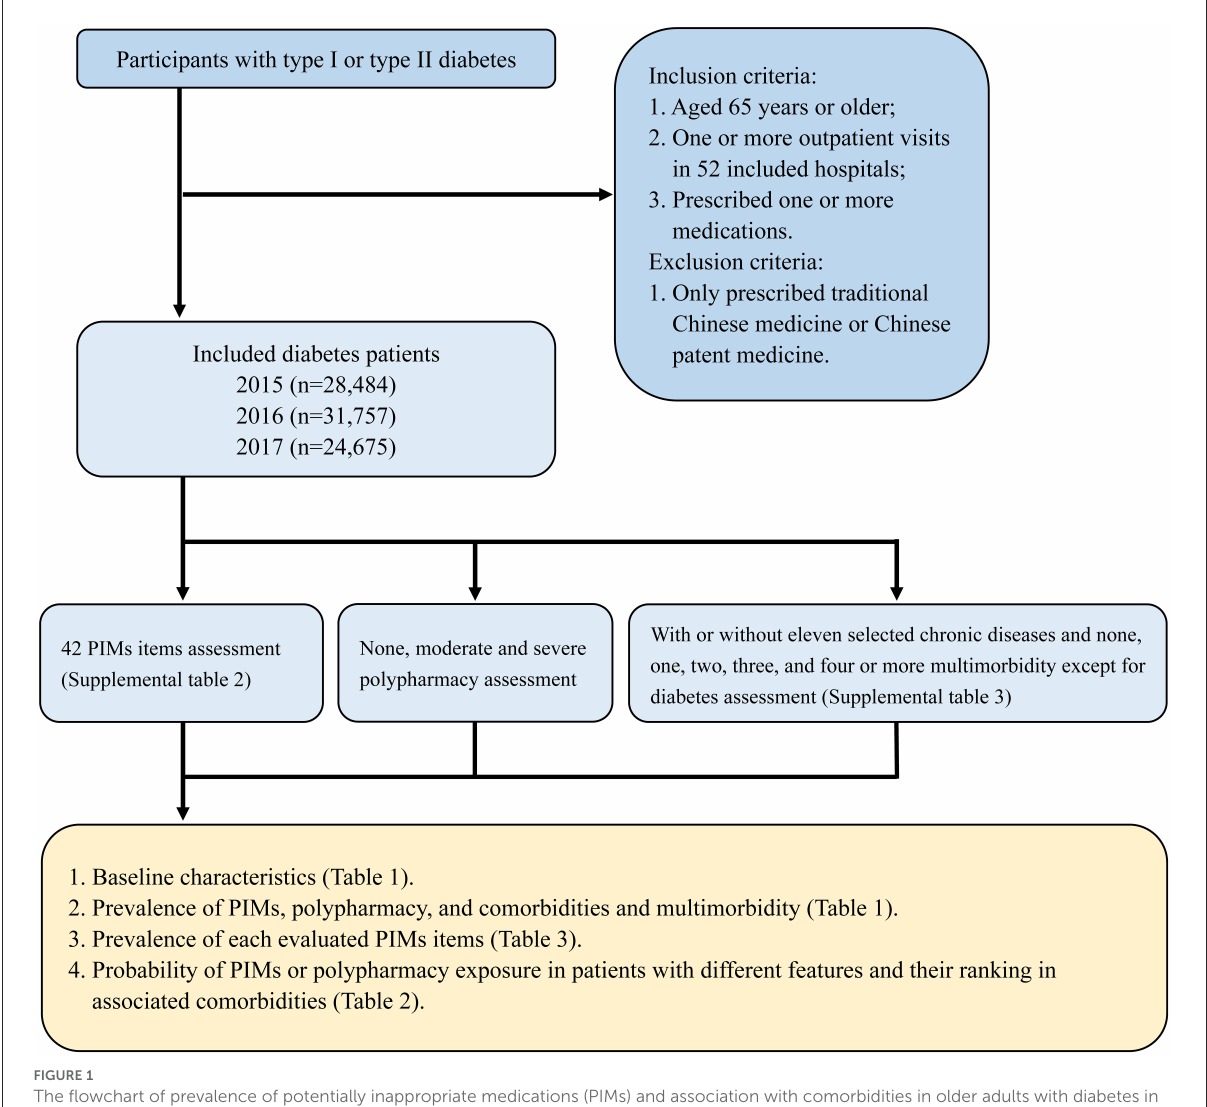
(95% CI 78.98–82.98), which was higher than in 2015 (76.43%, 95%CI 74.64–78.22) and 2016 (76.40, 95%CI